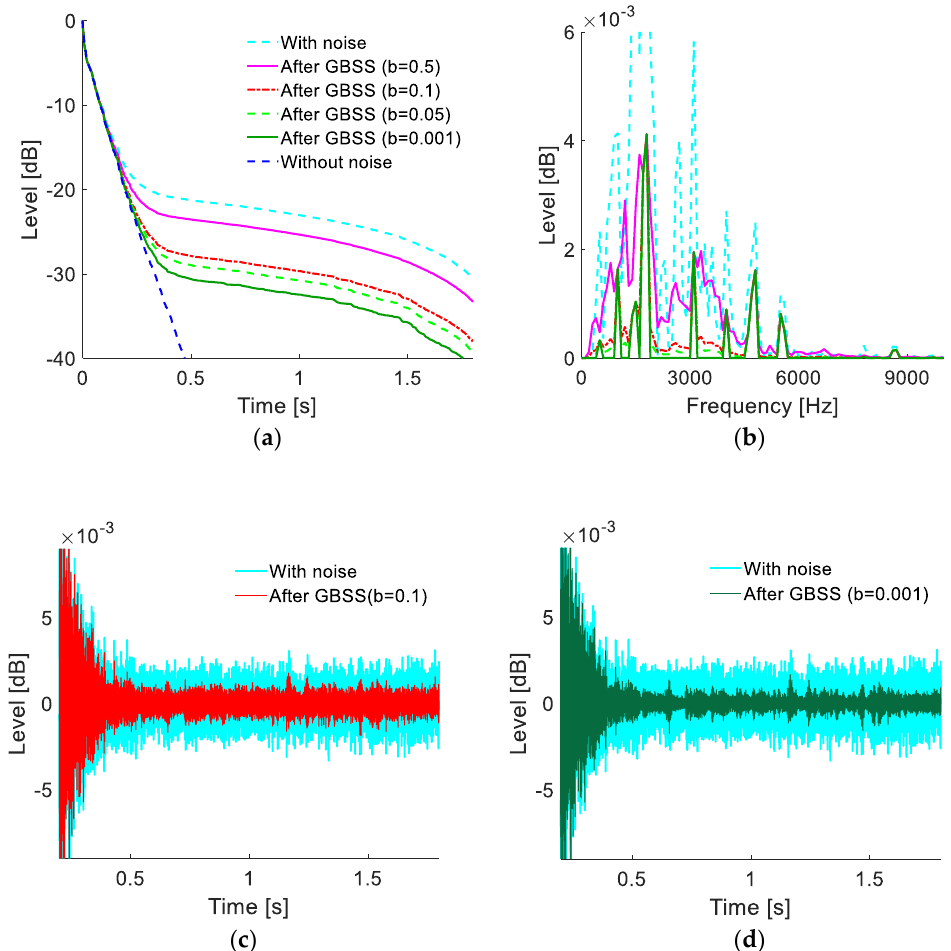
Figure 2. Comparison of the noisy RIRs and de-noised RIR at 1 kHz by varying the noise spectral floor 𝛽 for a fixed value of 𝛼 0 . ( a ) The EDCs of the RIRs. ( b ) Power spectrum of the RIRs obtained using the FFT. ( c , d ) RIRs in the time domain.